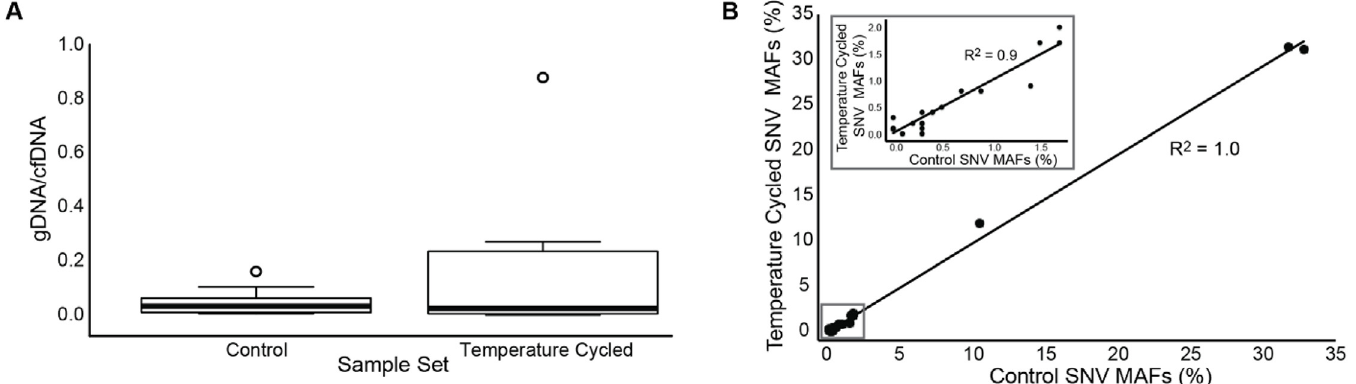
Fig 5. Guardant360 samples stressed by prolonged storage time and high temperature cycling do not impact performance. A) Extent of genomic DNA (gDNA from leukocytes) contamination in the control cell-free DNA (cfDNA) samples compared to prolonged temperature cycled samples sets represented as the ratio of gDNA ( > 500 bps) to cfDNA ( < 500 bps). Temperature cycled samples were incubated at 37°C for 8 hours followed by 16 hours at room temperature daily for 5 days. Control samples were processed immediately upon receipt at the laboratory. Center lines show the medians; box limits indicate the 25 th and 75 th percentiles as determined by R software; whiskers extend 1.5 times the interquartile range from the 25 th and 75 th percentiles, outliers are represented by dots. N = 10 sample points. B) Concordance of control sample set with prolonged temperature cycled sample set shown by a correlation plot of all mutant allele frequencies (MAFs) of the single nucleotide variants (SNVs) from the control sample set versus the corresponding SNV MAFs in the temperature cycled sample set. The total number of different SNVs plotted is 24. The inset shows the correlation of MAFs at less than or equal to 2% between the two data sets, showing excellent correlation even when SNVs are as low as 2.5%.